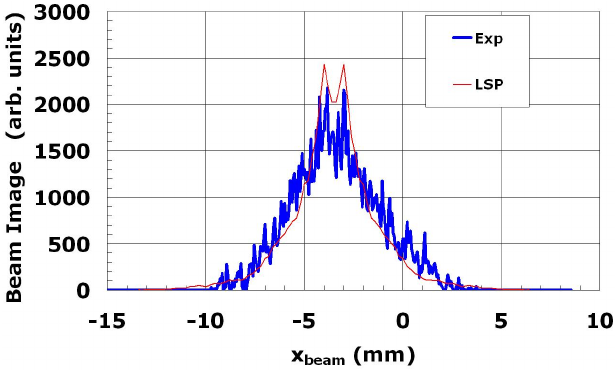
FIG. 8. (Color) The beam current density in the x plane inte- grated over all y is plotted for the NDCX measured (scanned on April 19, 2007) and L SP simulation values at z (cid:5) 414 cm